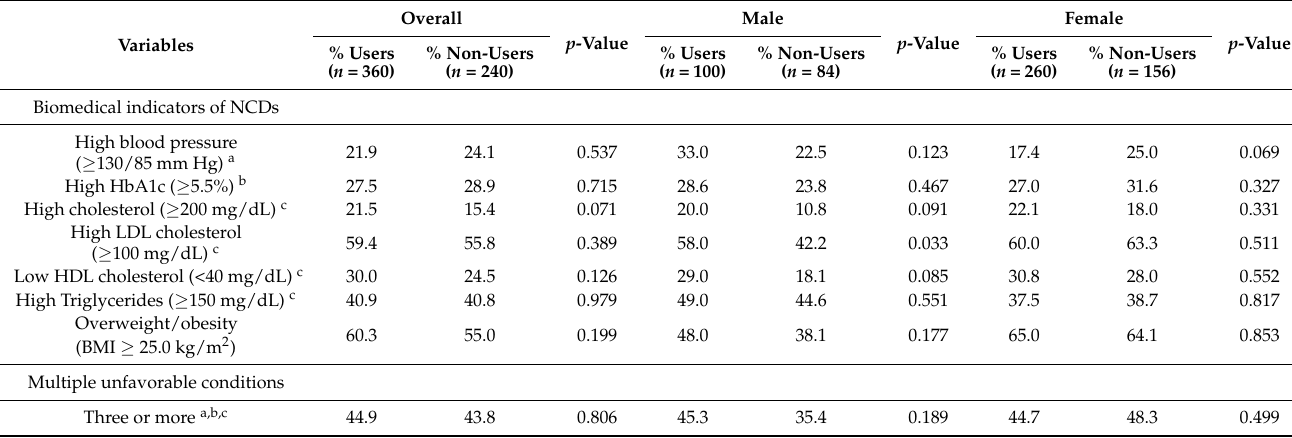
Table 5. Biomedical indicators related to non-communicable diseases and comorbidities by gender and status of health service use in the previous 12 months among schoolteachers in Afghanistan ( n =